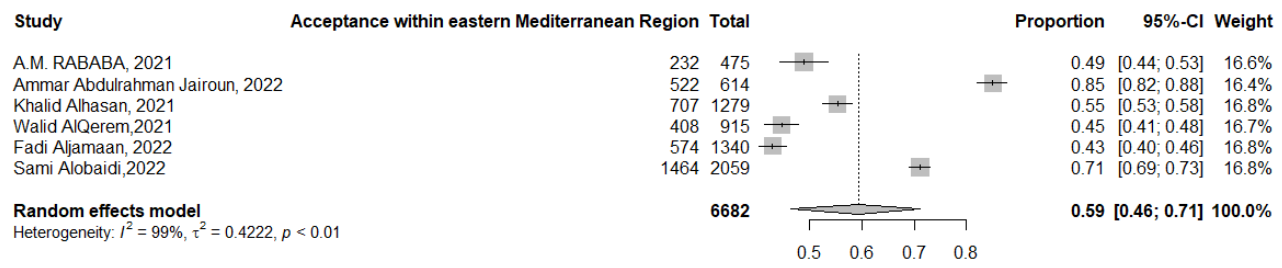
Figure 10. Acceptance of COVID-19 booster dose vaccination in the Eastern Mediterranean region.